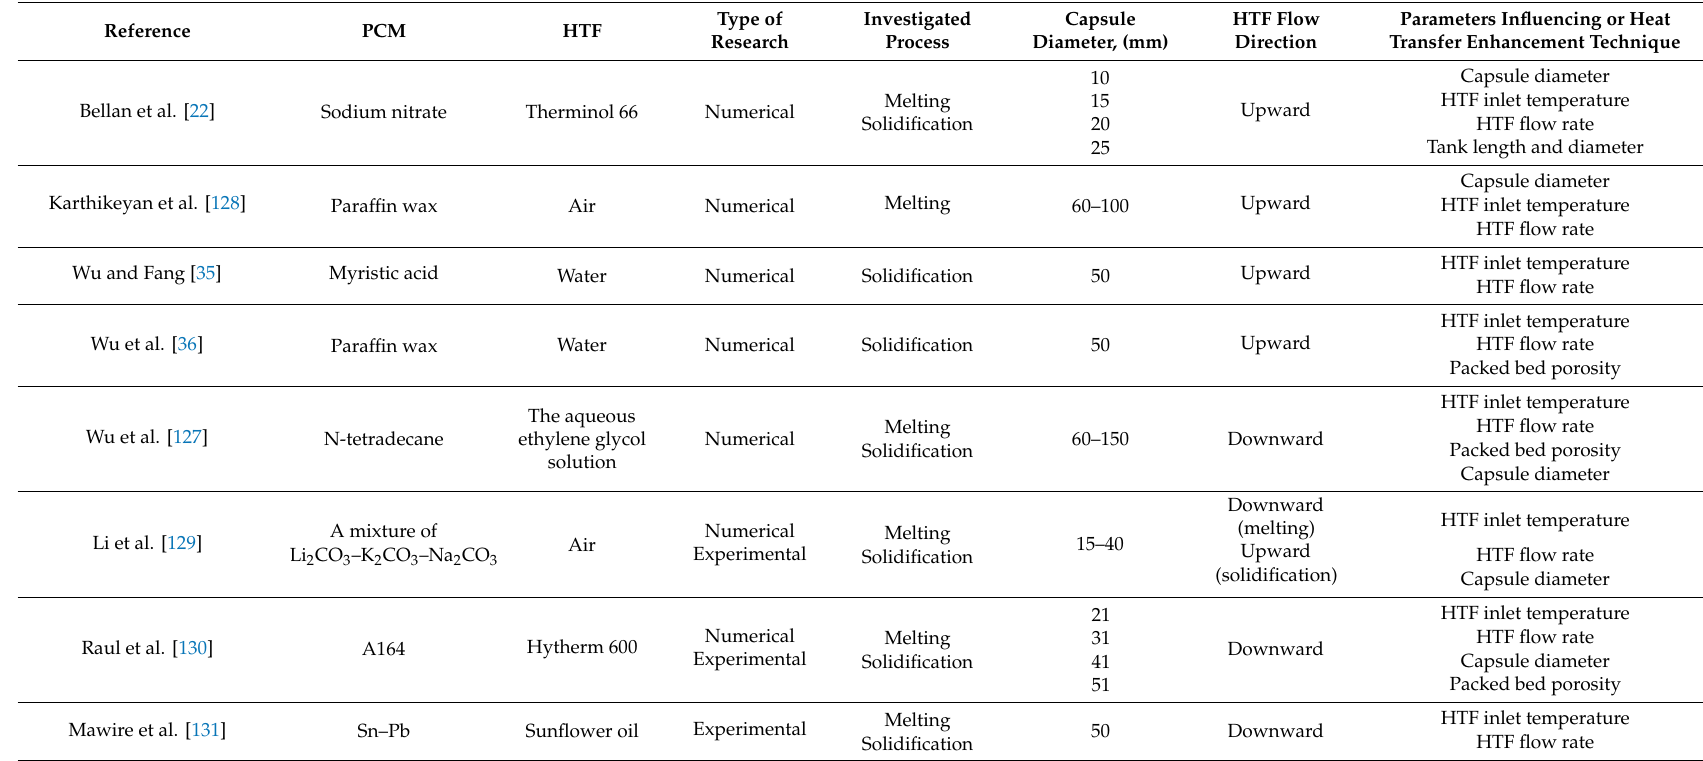
Table 7. Research on the heat exchangers with encapsulated